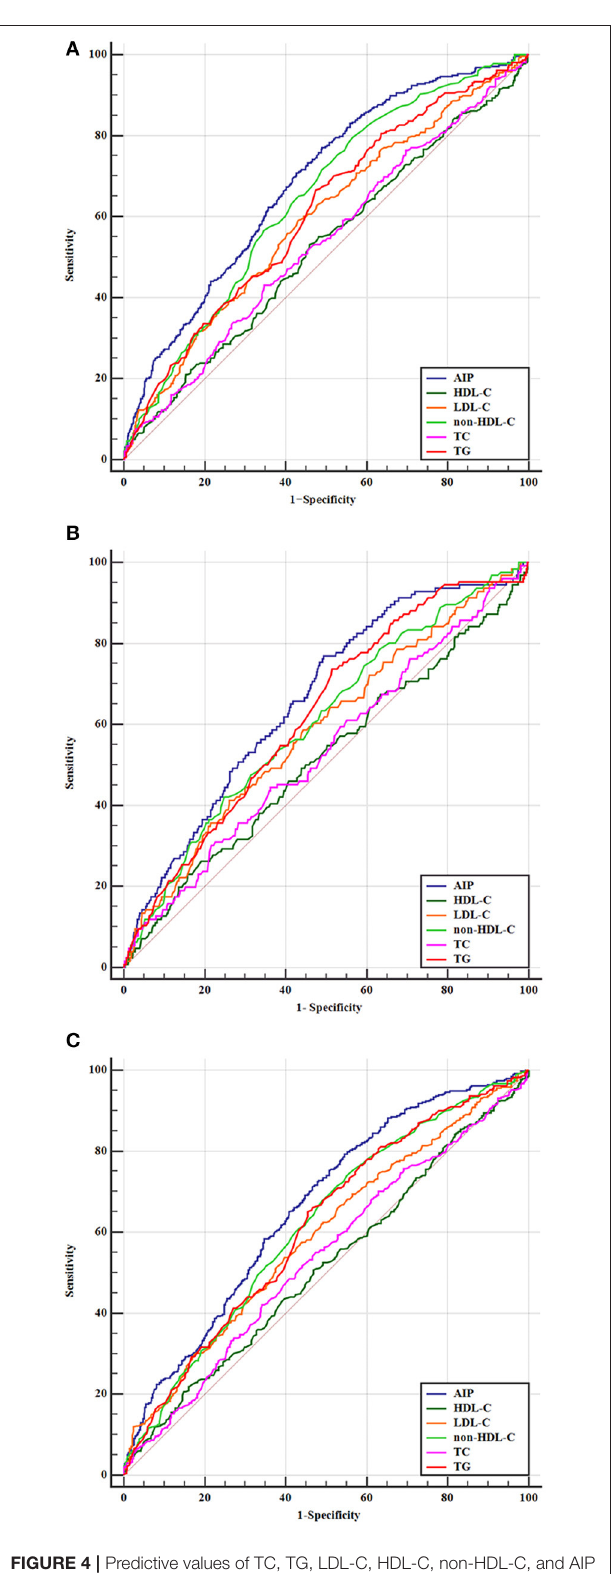
FIGURE 4 | Predictive values of TC, TG, LDL-C, HDL-C, non-HDL-C, and AIP for the outcomes. Receiver operating characteristic curves for outcomes. (A)